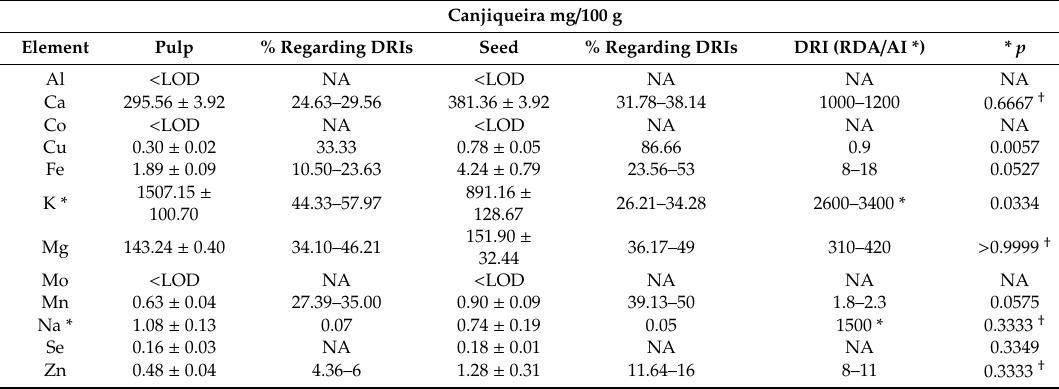
Table 3. Mineral content in pulp and seed of canjiqueira mg / 100 g (dry